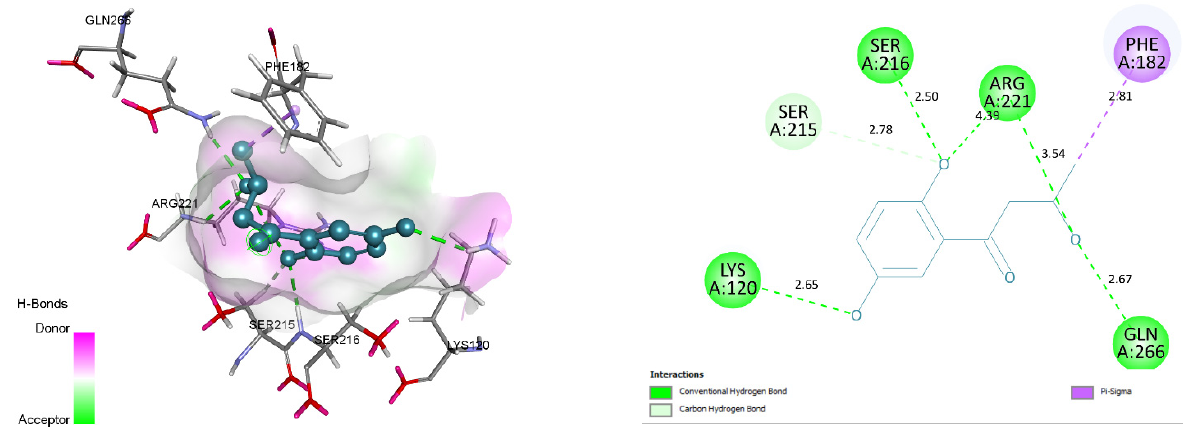
Figure 8. Docking view of ZINC31168554 in the binding sites of PTP1B (PDB ID: 1AAX). On theleft side is the stereo view of the docked complex- ZINC31168554 and 1AAX, on the right side ZINC31168554 -1AAX interactions are presented in 2D. Diagrams are drawn in Discovery Studio, hydrogen-bonds are shown as a green-dashed line along with the distance in Å. Protein structure residues are annotated with a 3-letter amino acid code, while ZINC31168554 is presented in ablue-colored ball and stick style.